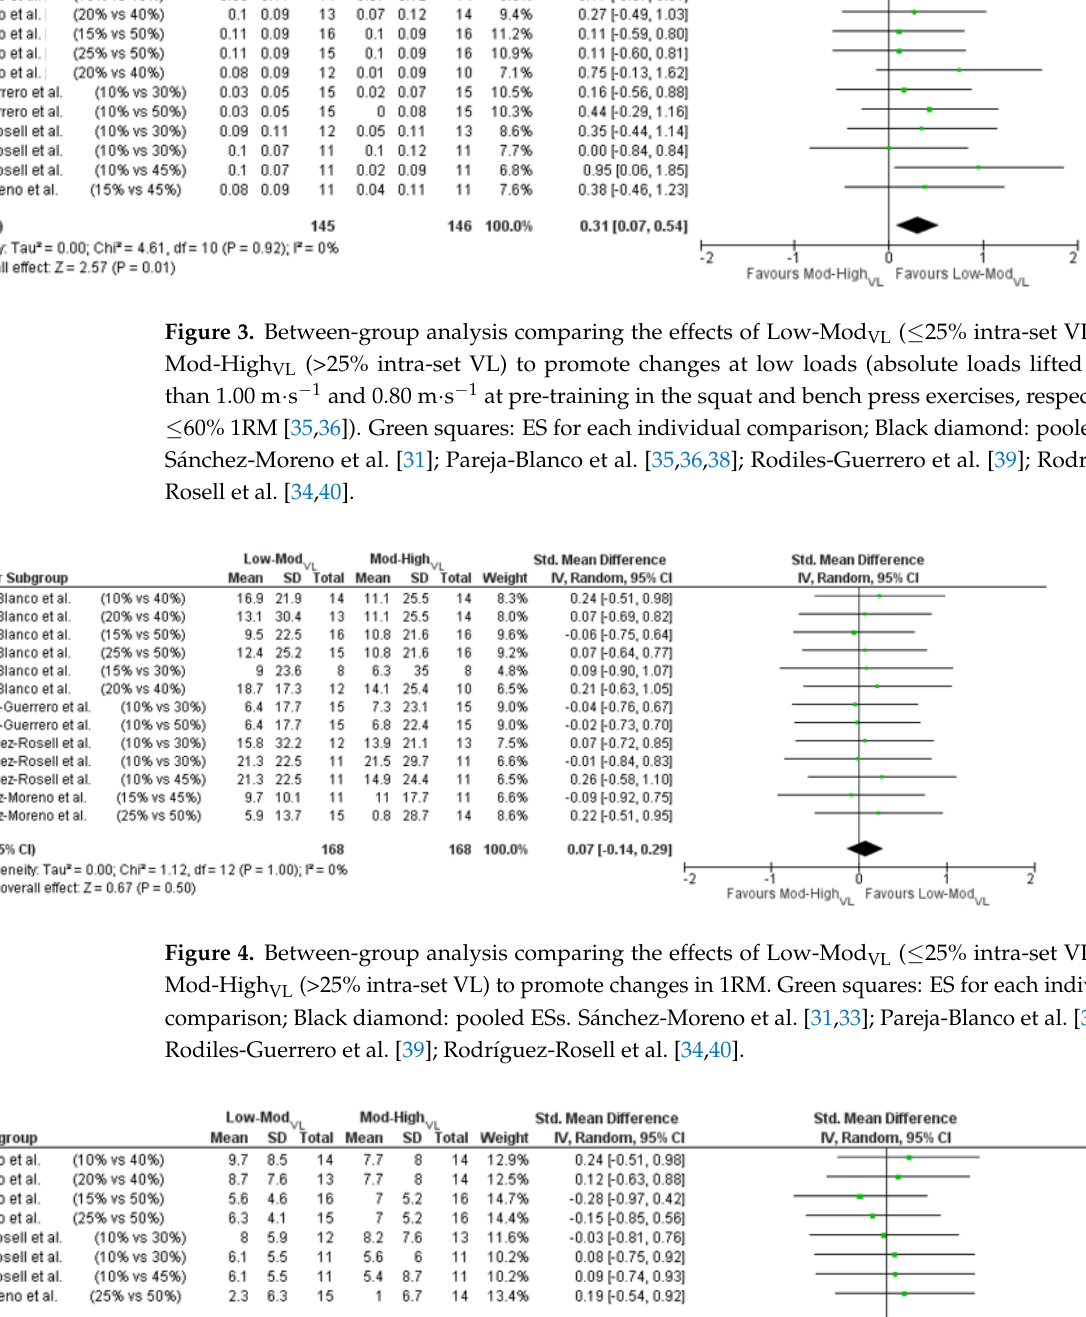
Low-Mod VL (≤25% intra -set VL); Mod-High VL (>25% intra-set VL); k : number of groups; RSR: relative strength ratio (1RM/Body mass); reps: repetitions; *** significant differences between VL thresholds ( p ≤ 0.001).